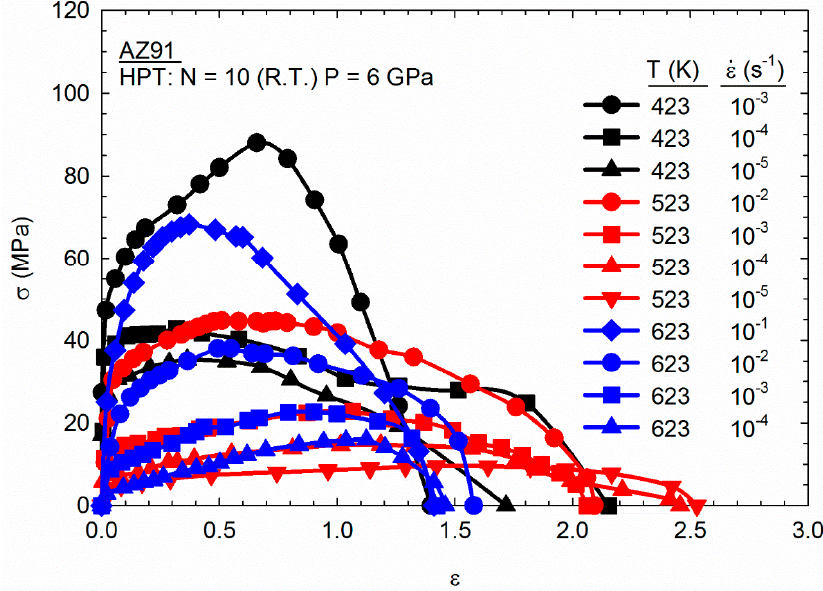
ff erent testing temperatures and strain